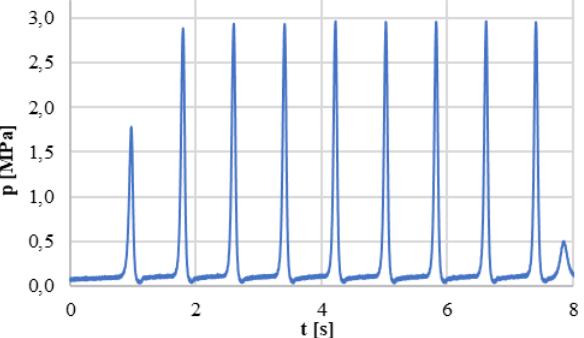
Fig. 6. The course of the compression pressure in the cylinder of the engine being tested The variable component of the starter current (resistance torque) can be the premise for determining the value of the air compression pressure in the engine cylinders. To deter- mine the value of the compression pressure, it is necessary to build a model for the engine crankshaft driving that al- lows correlating the pressure value and the current drawn by the starter. An example of the course of current during the engine crankshaft driving is shown in Fig.